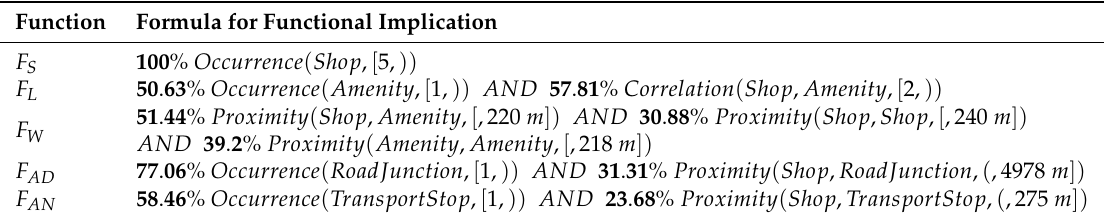
Table 7. Probabilistic pattern for places functioning as shopping